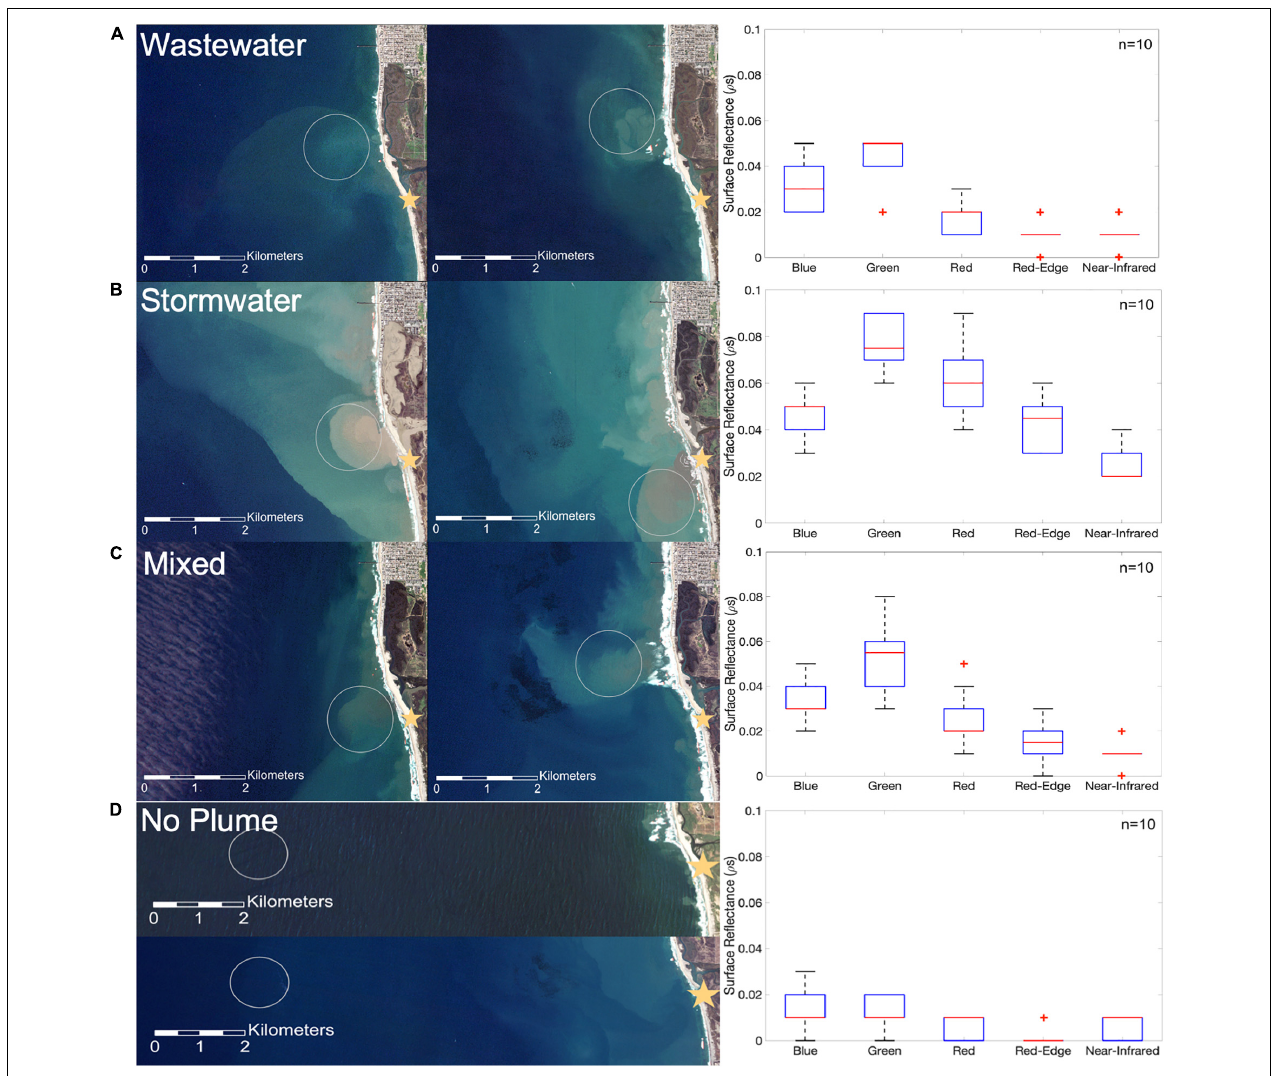
FIGURE 2 | Surface Reflectances for (A) Wastewater, (B) Stormwater, (C) Mixed, and (D) No event/No Plume. Images are the true color imagery from RapidEye with AOI circled. Box plots are the surface reflectance values for each plume type (10 events per type). A yellow star denotes the Tijuana River mouth. (A) Wastewater Plume Events: on 1/24/19 (left image): 610 million gallons (MG) of raw wastewater (occurred on 1/18 and ended on 1/30). 12/11/18 (right image): 147.7 MG of raw wastewater (occurred on 12/11 and ended on 12/24). (B) Stormwater Plume Events: 12/7/18 (left image): precipitation amount was 1.07 inches (2.7 cm) on 12/6/18 and flow rate hourly mean was 158.3 cms. 1/28/10 (right image): precipitation amount was 0.07 inches (0.18 cm) on 1/26/10 and no data available for flow rate. (C) Mixed Plume Events: 2/9/17 (left image): 143 MG of raw wastewater (occurred on 2/6/17 and ended on 2/23/2017), precipitation amount on 2/7 was 0.19 inches (0.48 cm), and flow rate hourly mean was 2.4 cms. 1/24/16 (right image): 23.7 MG of raw wastewater (occurred on 1/16/16 and ended on 1/24/16), precipitation amount on 1/23/16 was 0.4 inches (1 cm), and flow rate hourly mean was 0.2 cms. (D) No Plume Events: 3/23/17 (top image) and 12/16/15 (bottom image): no wastewater or precipitation events for at least a month. The AOI is extracted offshore due to natural sedimentation near the coast, which may influence surface reflectance values. For each box plot, the median is shown by the red mark, the whiskers correspond to the maximum and minimum values, the red plus signs show the outliers outside of the 25–75 percentile range shown by the